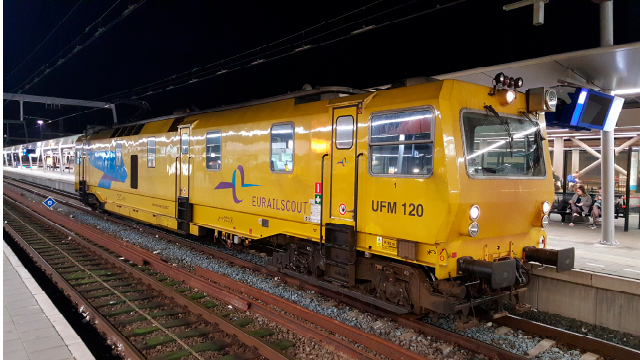
Figure 3. EURAILSCOUT UFM120 measuring coach [48]. Table 1. Technical data of UMF120 measuring coach.